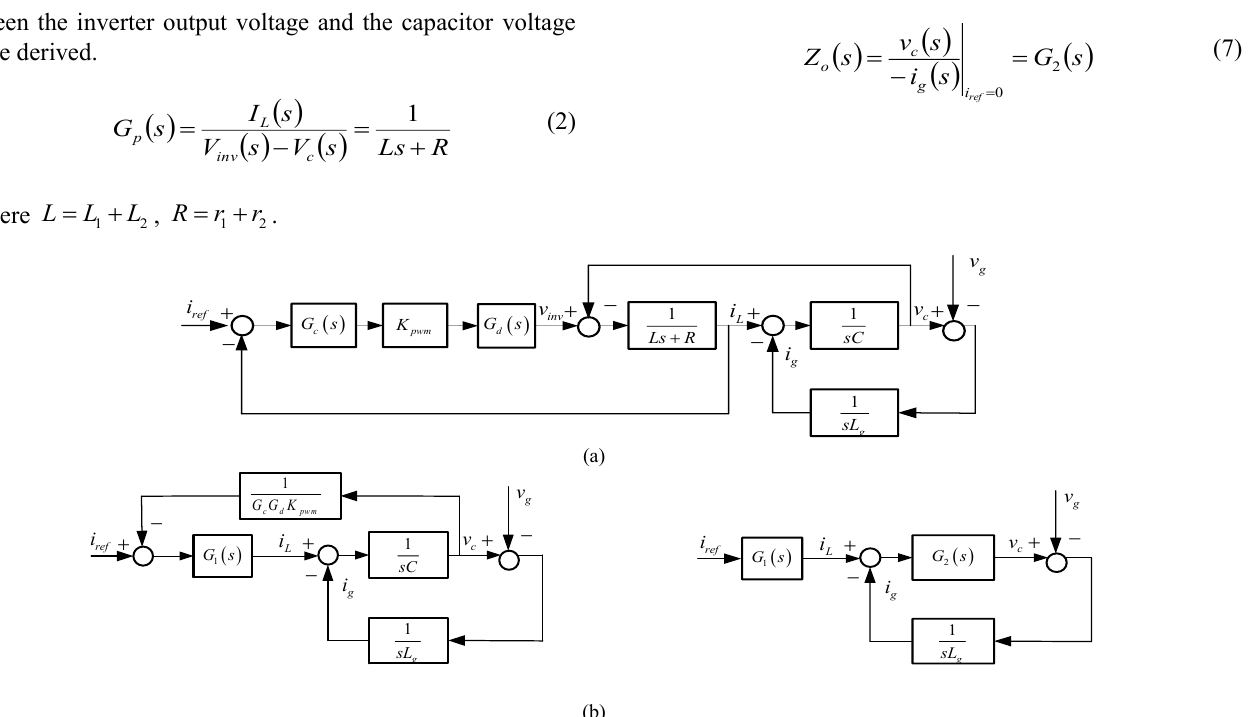
(b) Fig. 2. Control block diagram for a single-phase grid connected inverter (a) and its equivalent transformation